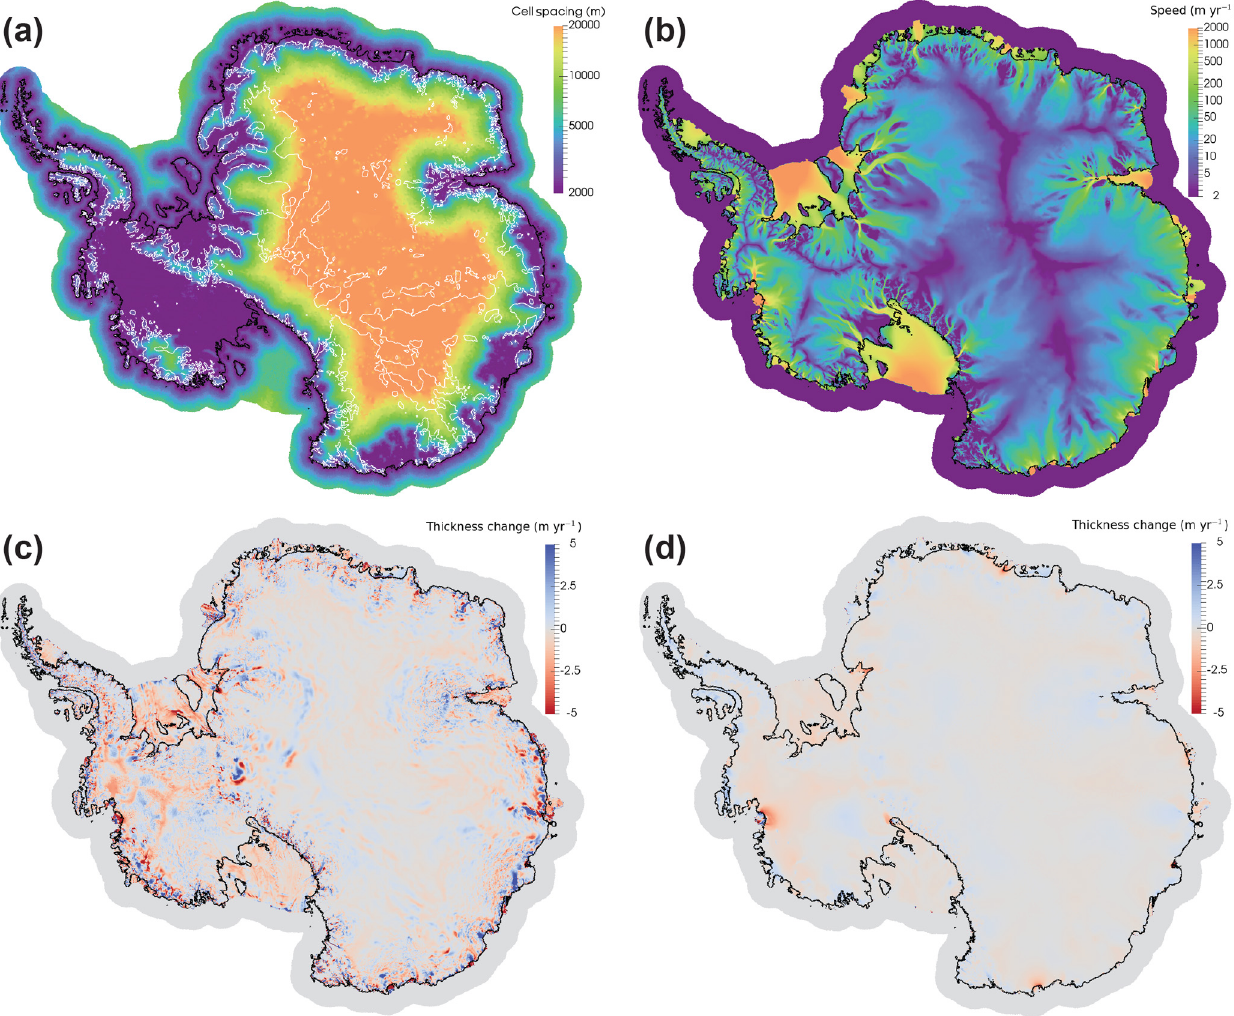
Figure 12. (a) Mesh resolution used for initMIP simulations. The black line is the grounding line at the end of the relaxation and the white line is the bed topography contour at sea level. (b) Modeled ice surface speed at the end of relaxation. The black line is the grounding line. (c) Thickness rate of change at the start of relaxation. (d) Thickness rate of change at the end of relaxation (99